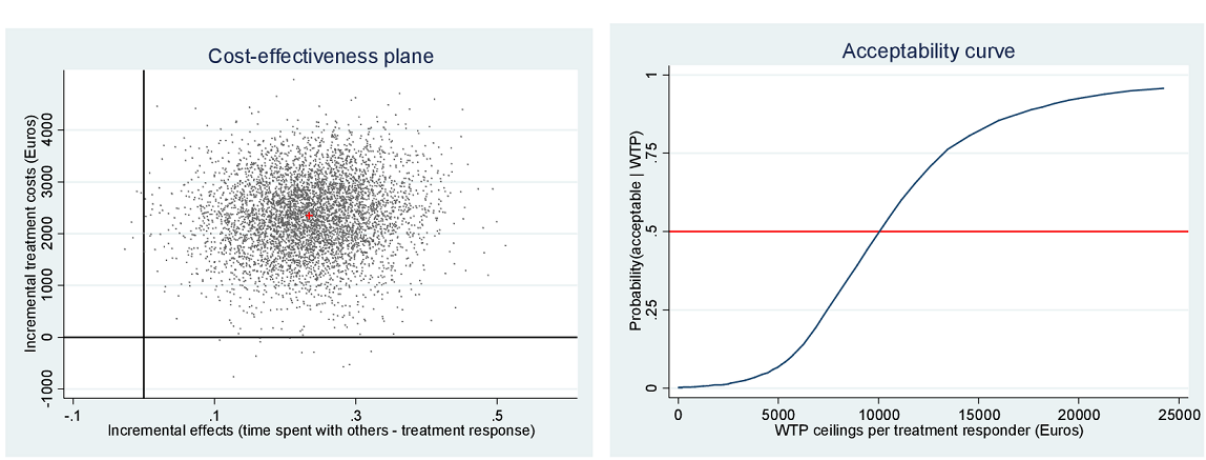
Figure 2. Cost-effectiveness plane and willingness to pay (WTP) acceptability curve for time spent with others.